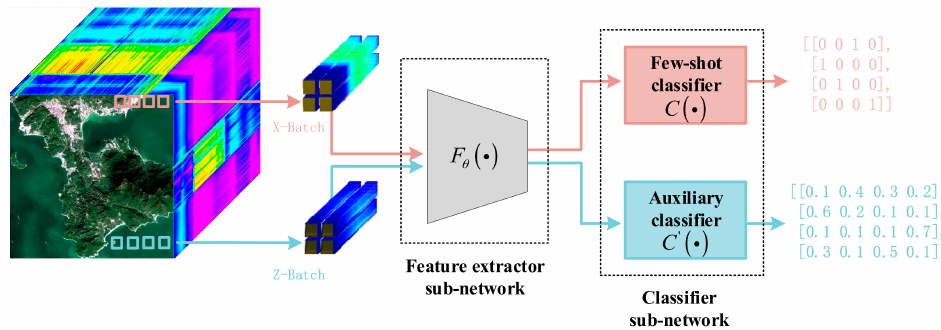
Figure 1. Pipeline of the proposed two-branch few-shot deep learning framework for HSI